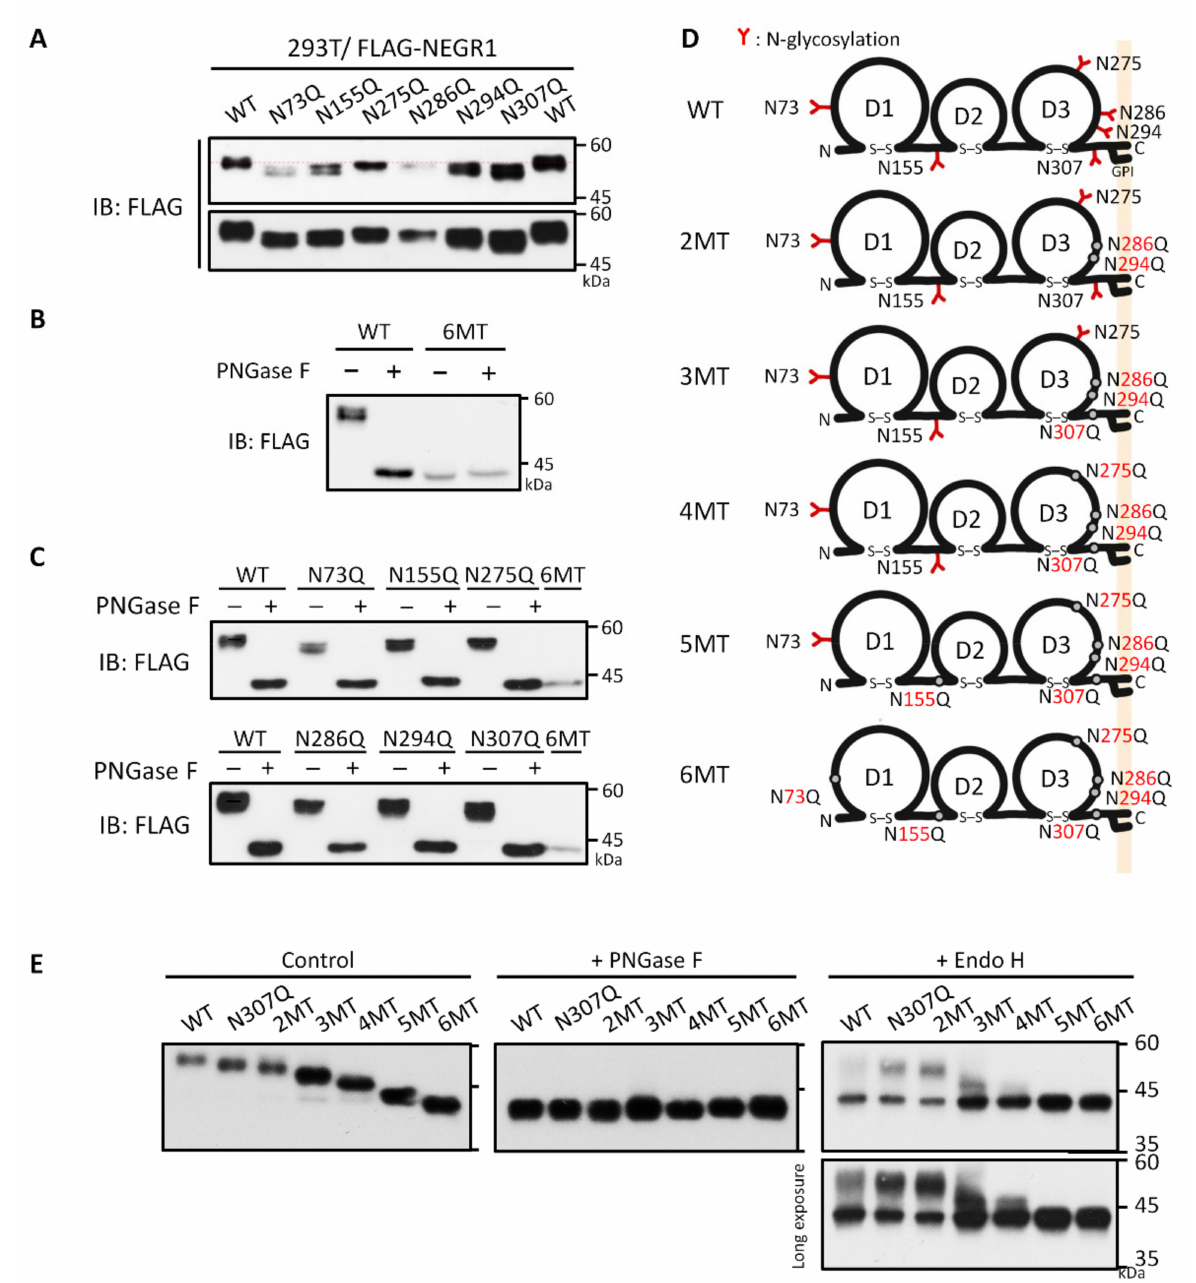
Figure 2. Generation of NEGR1 N -glycosylation mutants. ( A ) Immunoblotting of 293T cell lysates expressing N -glycosylation site-specific NEGR1 single mutants. ( B ) Deglycosylation of the NEGR1 6MT mutant, which contained all six N -glycosylation site mutations. The 293T cell lysates expressing wild type (WT) or 6MT NEGR1 were subjected to PNGase F digestion. ( C ) PNGase F digestion of each single N -glycosylation mutants. ( D ) Schematic representation of NEGR1 mutants (2MT–6MT), containing additive mutations in the following order: 286/294, 307, 275, 155, and 75. ( E ) NEGR1 WT and cumulative mutants were transfected into 293T cells and then subjected to enzymatic